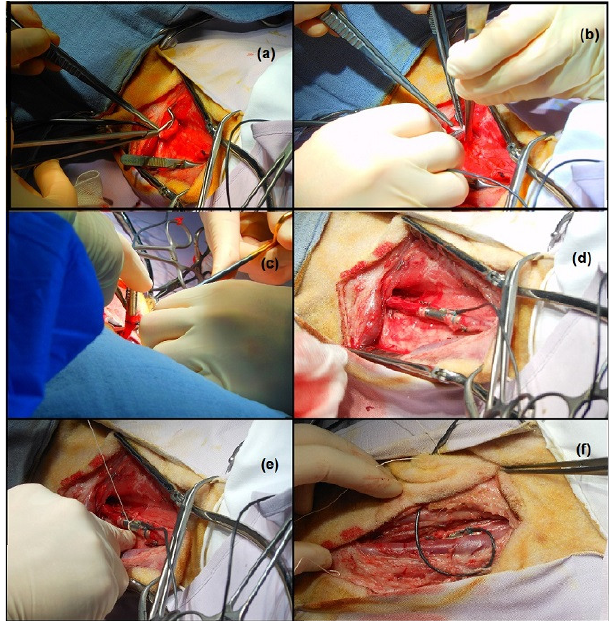
Figure 13. Pressure sensor implant, surgical procedure: ( a ) Carotid artery transection; ( b – d ) Insertion of the sensor tube; ( e ) Stitching of the tube on the underlying muscle; ( f ) Subcutaneous tunneling of the sensor’s